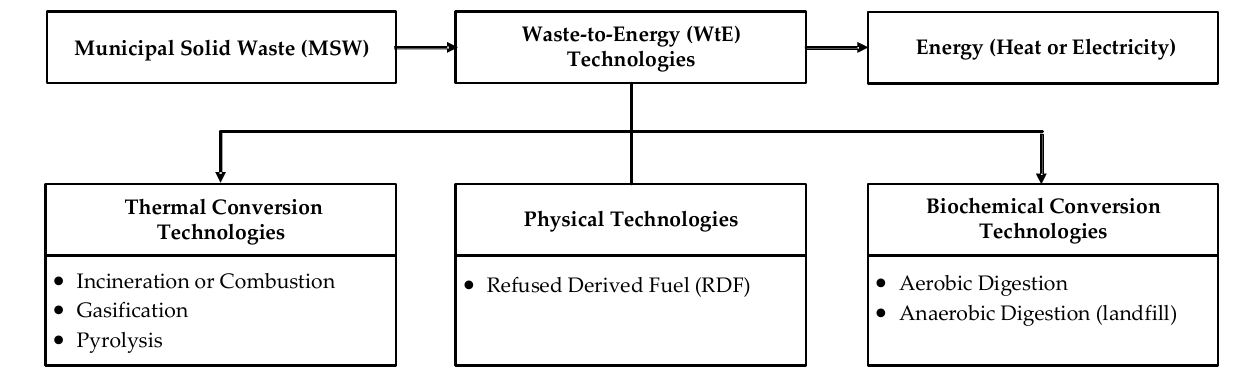
Figure 1. Types of WtE technologies.